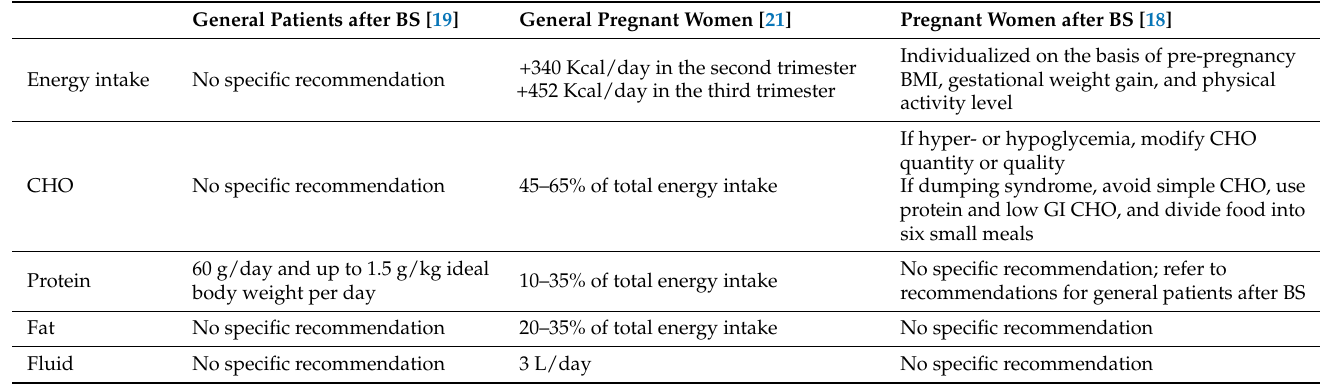
Table 2. Macronutrient recommendations for general patients after BS, general pregnant women, and pregnant women after BS. CHO: carbohydrates; GI: glycemic index; BMI: body mass